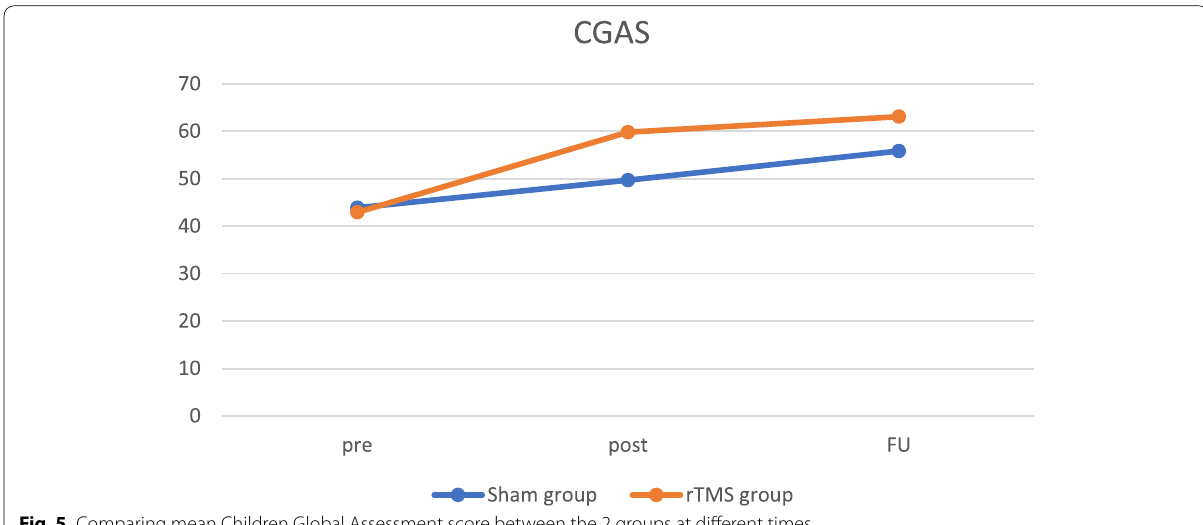
Fig. 5 Comparing mean Children Global Assessment score between the 2 groups at different